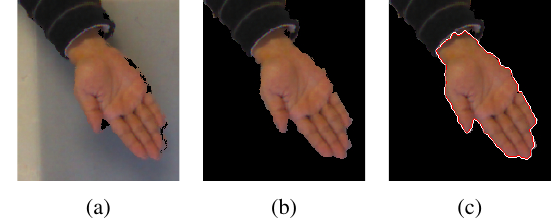
Figure 2: Procedure of preprocessing. (a) A color image is aligned to the corresponding depth image. (b) The background of (a) is removed by using a thresholding filter. (c) Hand region is segmented by using FTC.